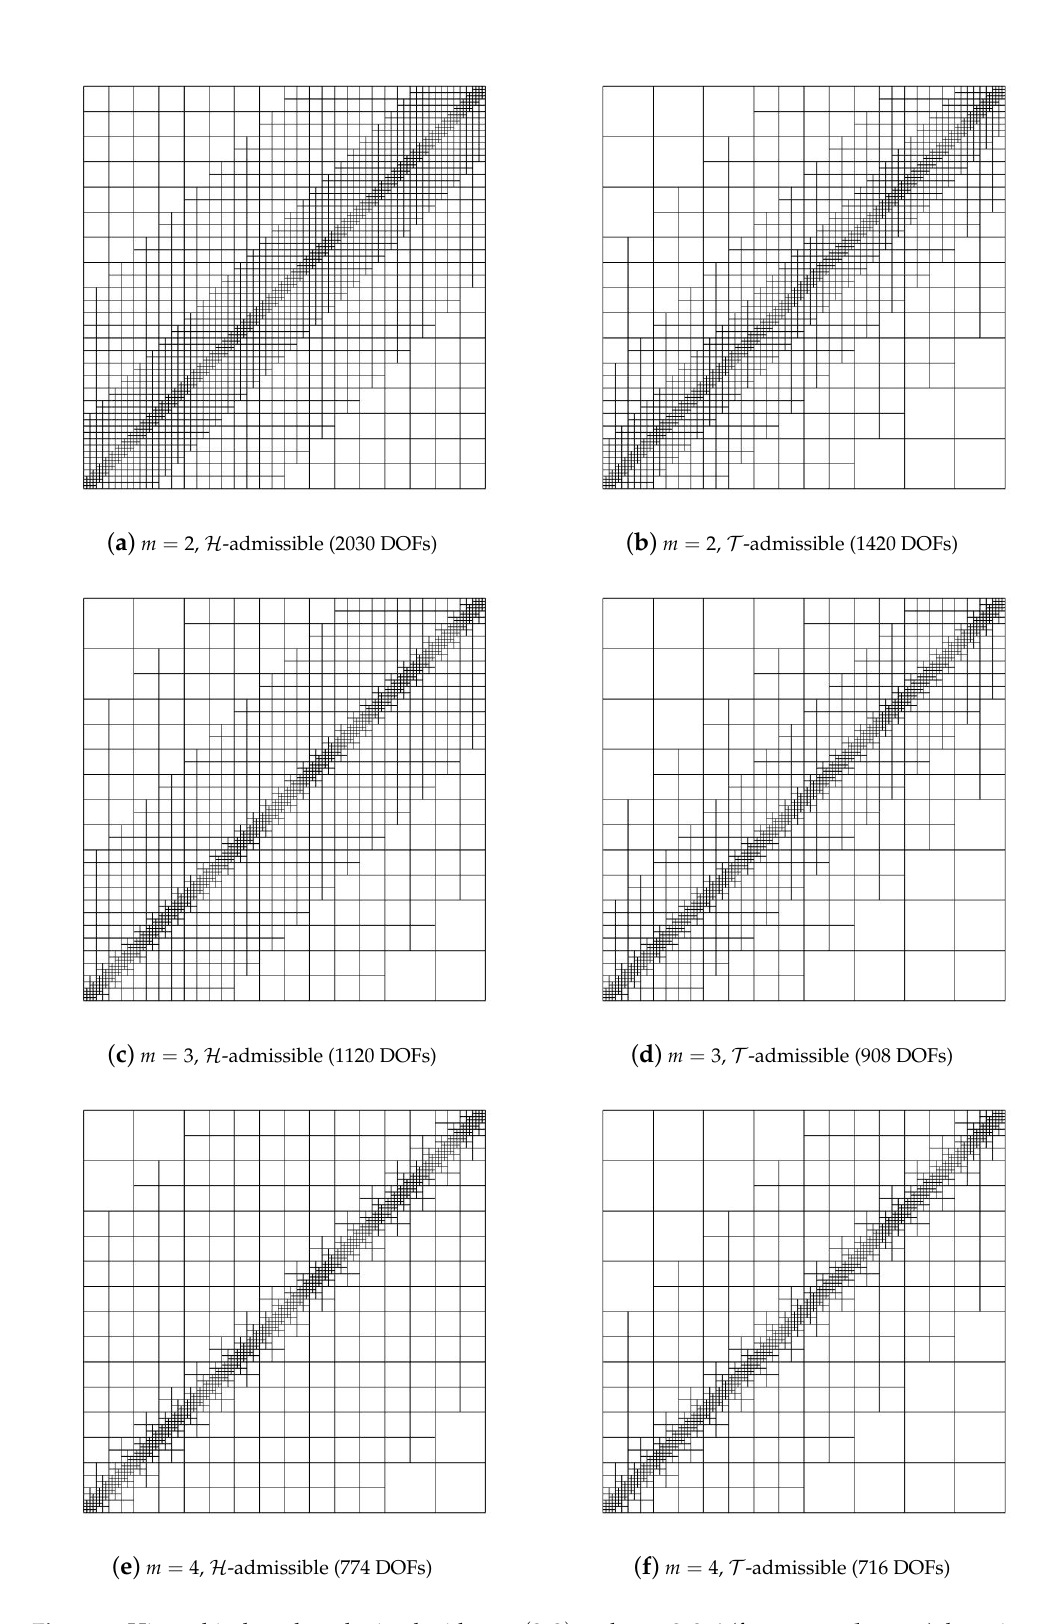
Figure 3. Hierarchical meshes obtained with p = ( 2,2 ) and m = 2,3,4 (from top to bottom ), by using H -admissible ( left ) and T -admissible ( right )